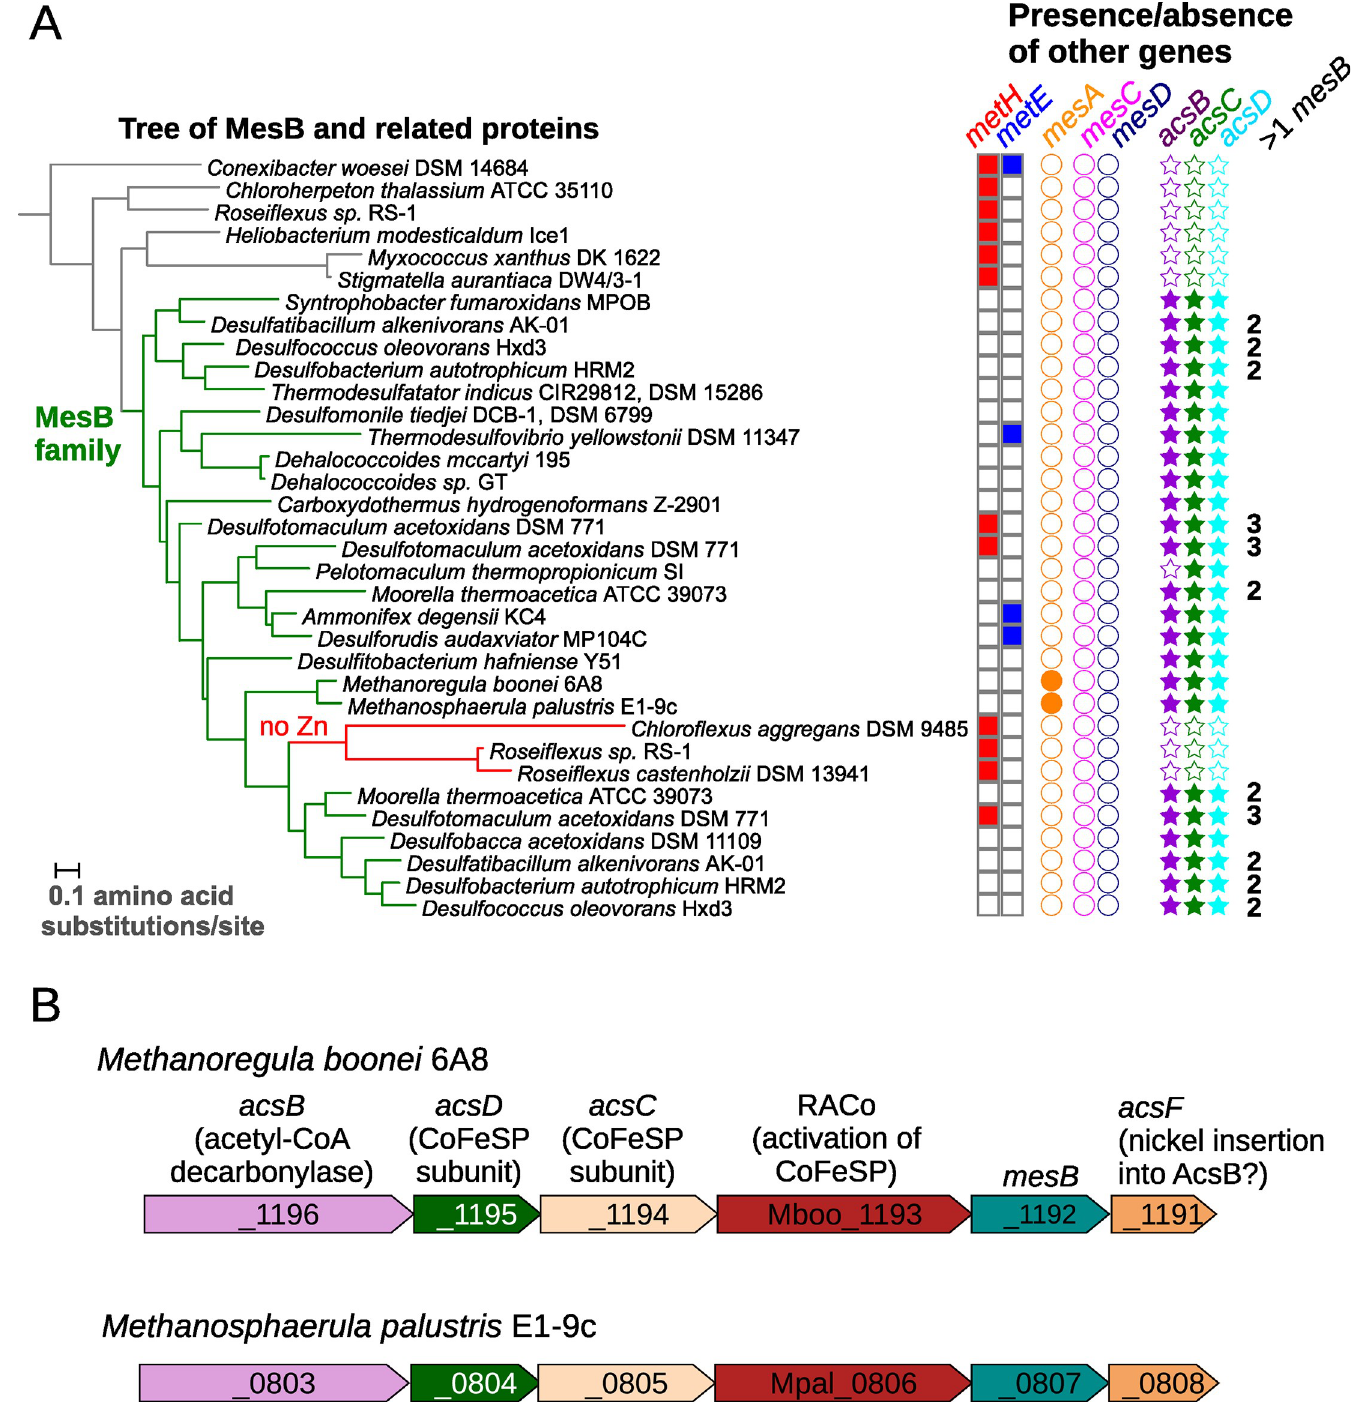
Fig 3. Comparative genomics links MesB to the Wood-Ljungdahl pathway. (A) A phylogenetic tree of MesB and related proteins. The MesB family is highlighted in green and a subfamily that lacks Zn-coordinating residues is highlighted in red. On the right, filled symbols indicate the presence in that genome of other methionine synthases or of the Wood-Ljungdahl pathway ( acsBCD , also known as cdhCED ). If the genome contains more than one mesB gene, we show the number. The tree and the genome properties were rendered with iTOL v5 (https://itol.embl.de/). (B) Conserved clustering of mesB with genes from the Wood-Ljungdahl pathway. Gene drawings were modified from MicrobesOnline